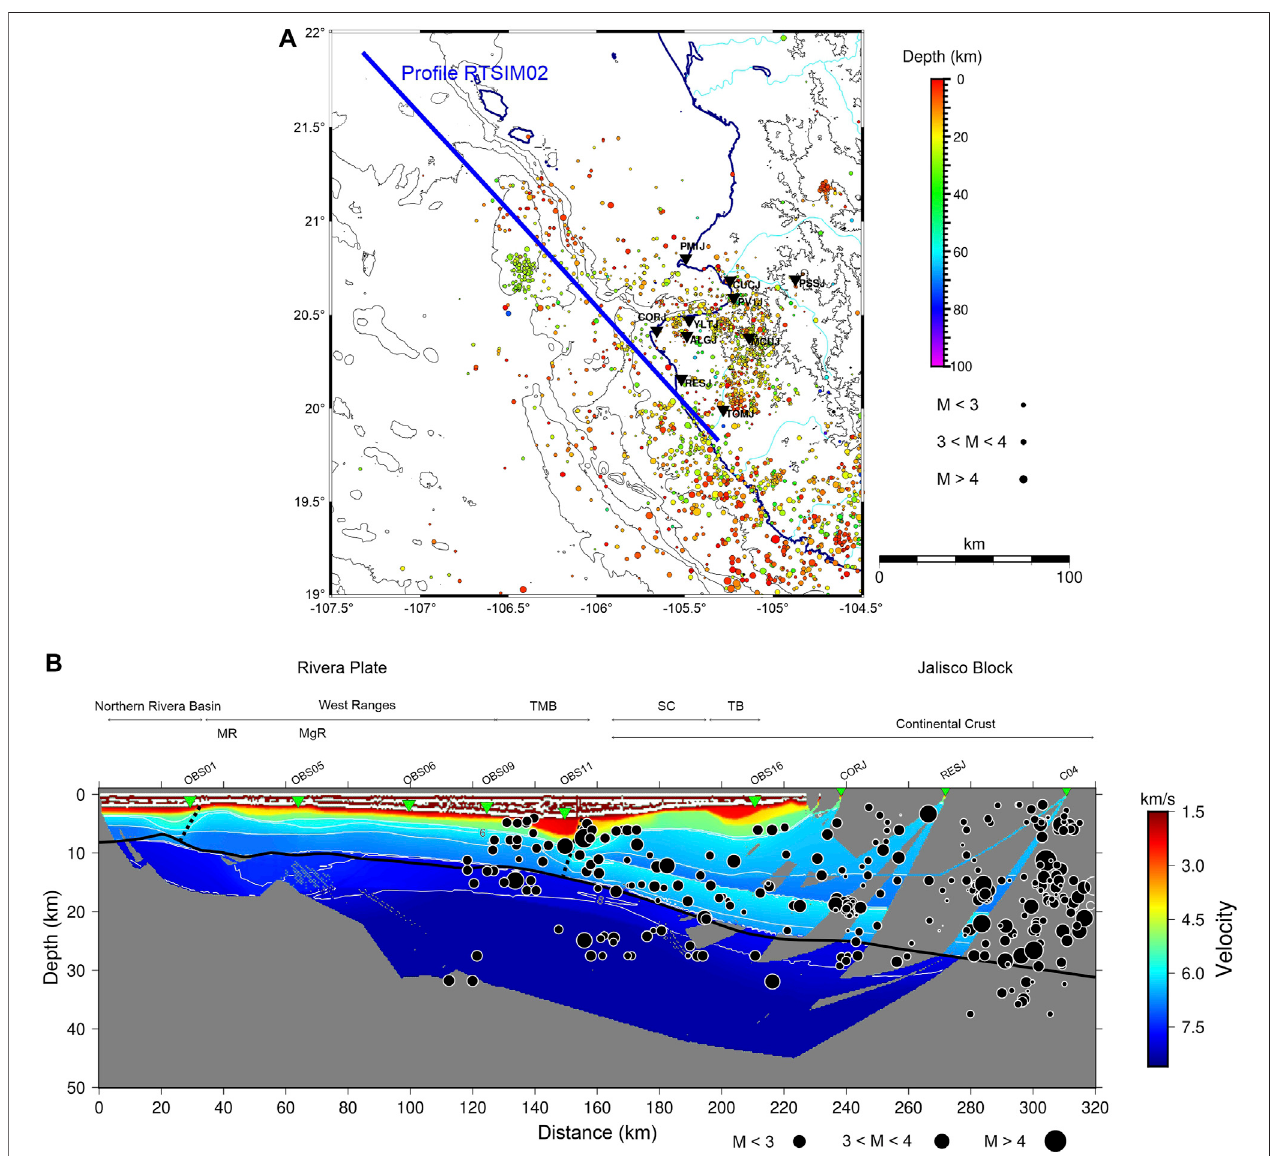
FIGURE10| (A) Seismicity map ofwestern Mexico. Datasources obtained from Gutiérrez-Pena et al.(2015), Marín-Mesa et al. (2019),Núñez-Cornú et al. (2002), Núñez-Cornú et al. (2004), Núñez-Cornú et al. (2014), Núñez-Cornú et al. (2018), Núñez-Cornú et al. (2020), Rutz-López and Núñez-Cornú (2004), Rutz-López et al. (2013), Tinoco-Villa (2015). The blue line is the projection of seismicity throughout the RTSIM02 seismic pro fi le with a width of 40 km. Black inverted triangles depict seismic stations which recorded these data. (B) RTSIM02 tomographic P-wave velocity model with the seismicity projected along the pro fi le depicted in Panel (A) (40 km of total width). Abbreviations as for Figure 7A